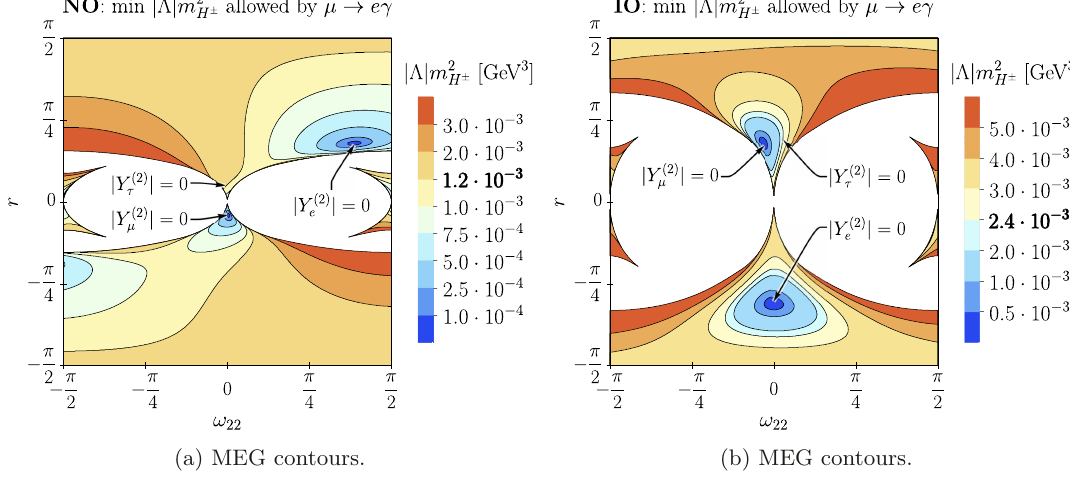
(a) MEG contours. Figure 6. Contour plots of lower limits of experiment. The white area is excluded theoretically, either by the constraint that z , eq. (2.26), has to be real, or by the constraint in eq. (2.27). The latter constraint is colored red striped in figure 3. The tiny regions around the points with Y (2) e = 0 and Y (2) µ = 0 are always allowed by µ eγ . They are constrained either by τ → photon factor correspond to the critical cases when µ